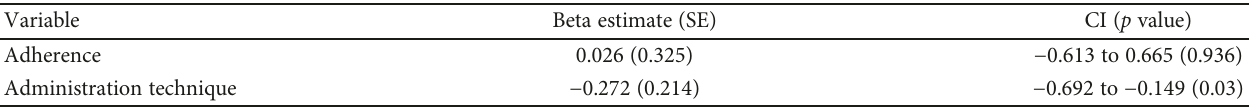
Table 2: Association of intraocular pressure with adherence and administration technique among patients attending the glaucoma clinic of Menelik II Hospital,